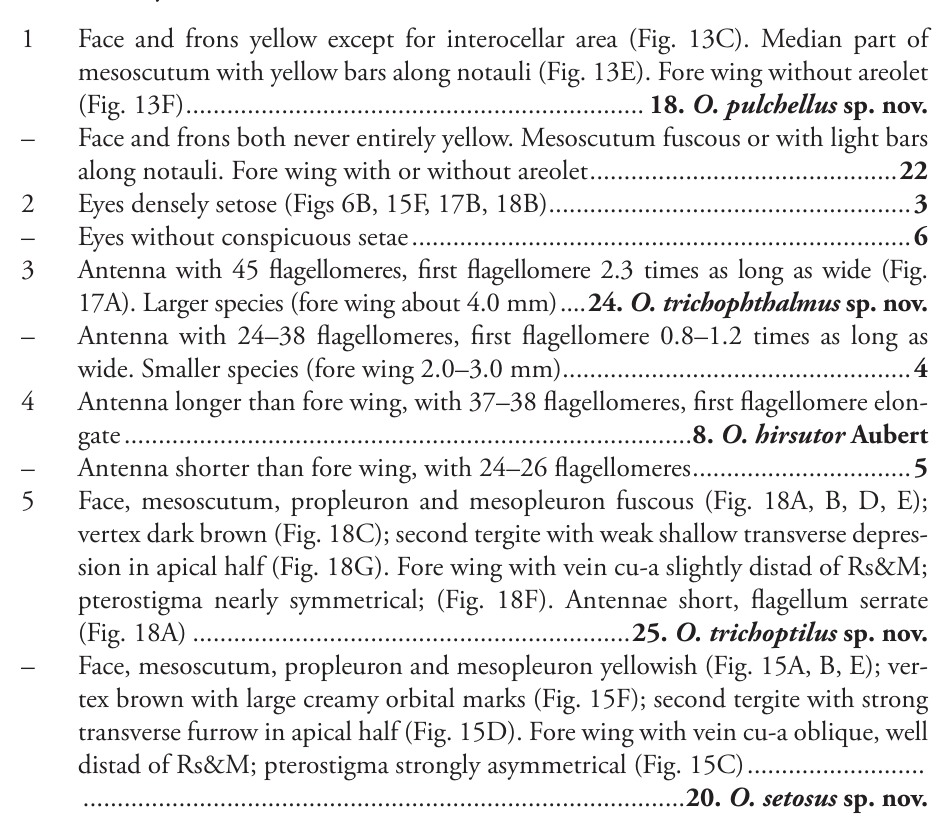
5 Face, mesoscutum, propleuron and mesopleuron fuscous (Fig. 18A, B, D, E); vertex dark brown (Fig. 18C); second tergite with weak shallow transverse depres- sion in apical half (Fig. 18G). Fore wing with vein cu-a slightly distad of Rs&M; pterostigma nearly symmetrical; (Fig. 18F). Antennae short, flagellum serrate (Fig. 18A) ................................................................ 25. O. trichoptilus sp. nov. – Face, mesoscutum, propleuron and mesopleuron yellowish (Fig. 15A, B, E); ver- tex brown with large creamy orbital marks (Fig. 15F); second tergite with strong transverse furrow in apical half (Fig. 15D). Fore wing with vein cu-a oblique, well distad of Rs&M; pterostigma strongly asymmetrical (Fig. 15C)